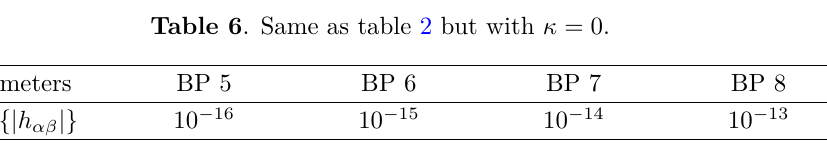
Table 7 . Same as table 3 but with κ = 0